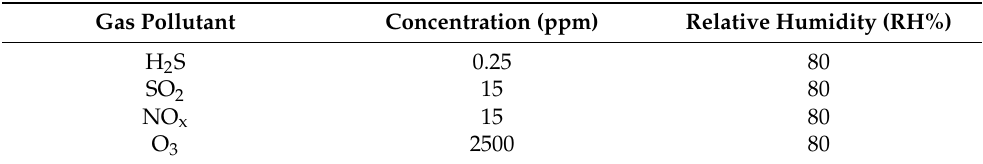
Table 1. Gas selected for the artificial accelerated aging and corresponding concentrations chosen. Gas Pollutant Concentration